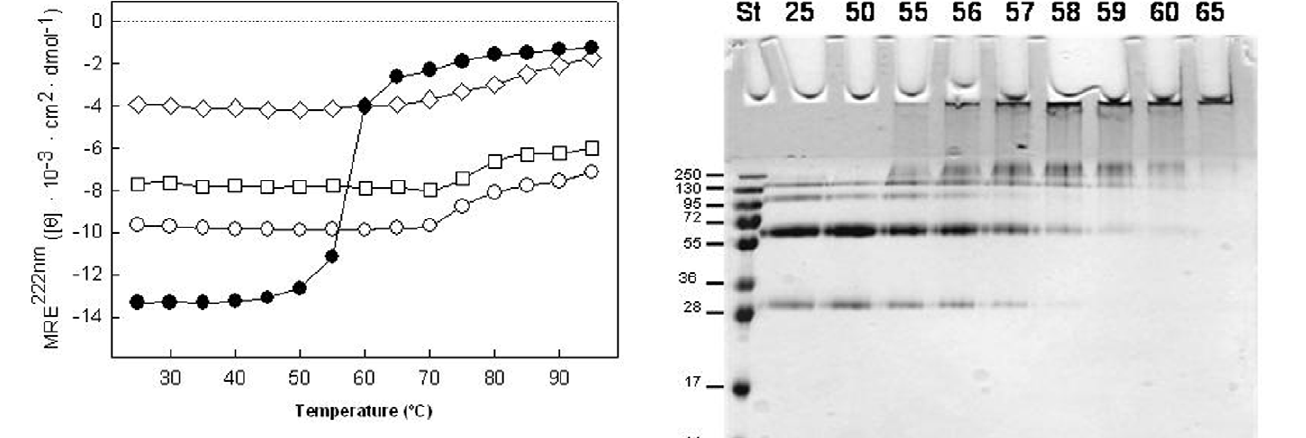
N Figure 3. MRE at 222 nm as a function of temperature. SoPIP2;1 ), E. coli lipid membranes ( % ), POPE:POPC:POPS:Er- in OG micelles ( gosterol ( o) and POPE:POPC ( e ). doi:10.1371/journal.pone.0014674.g003 Figure 4. Thermal denaturation of SoPIP2;1. It can be visualized by SDS-PAGE since large aggregates are formed that cannot enter the gel. After incubation at room temperature the normal bands corresponding to monomeric, dimeric, trimeric and tetrameric SoPIP2;1 are evident. No aggregates were found at 50 u C whereas at the melting point, 58 u C, as determined by CD, part of the protein was aggregated. At 65 u C the aggregation was complete. The samples were incubated at the indicated temperatures (25–65 u C) for 10 minutes before sample loading buffer was added followed by 10 minutes incubation at room temperature. St, standard with indicated Mw in kDa in the left side of the gel.